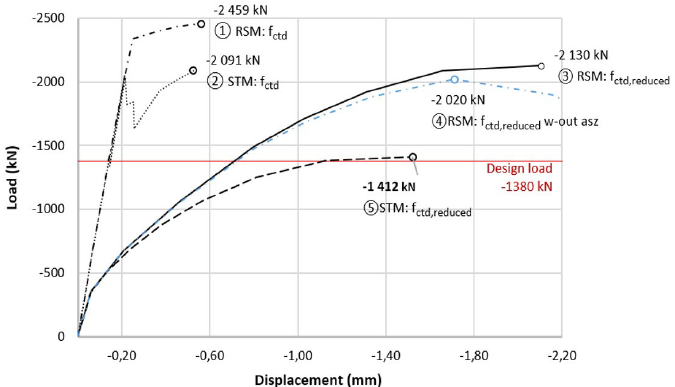
Figure 17. Load displacement curves for the performed numerical